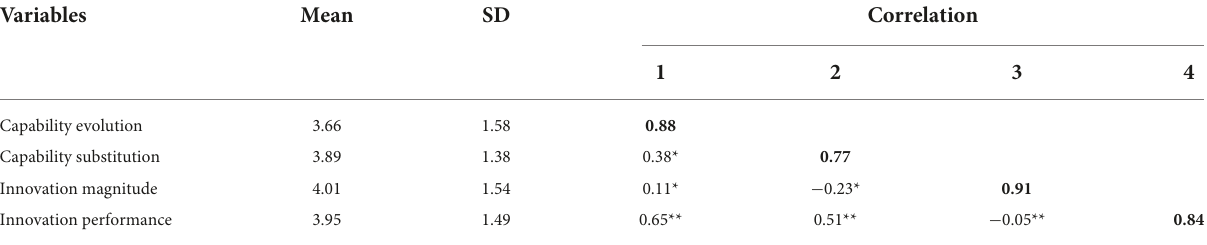
TABLE 3 Descriptive statistics and correlation